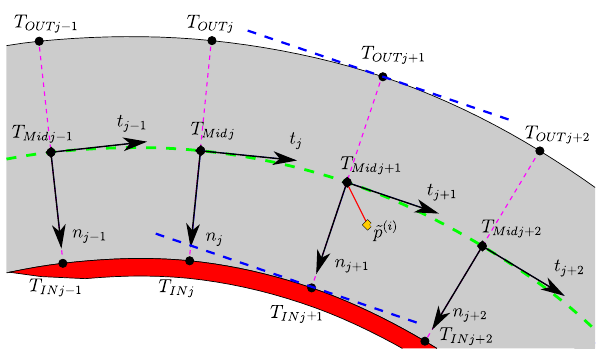
Figure 3. Representation of the racetrack linear